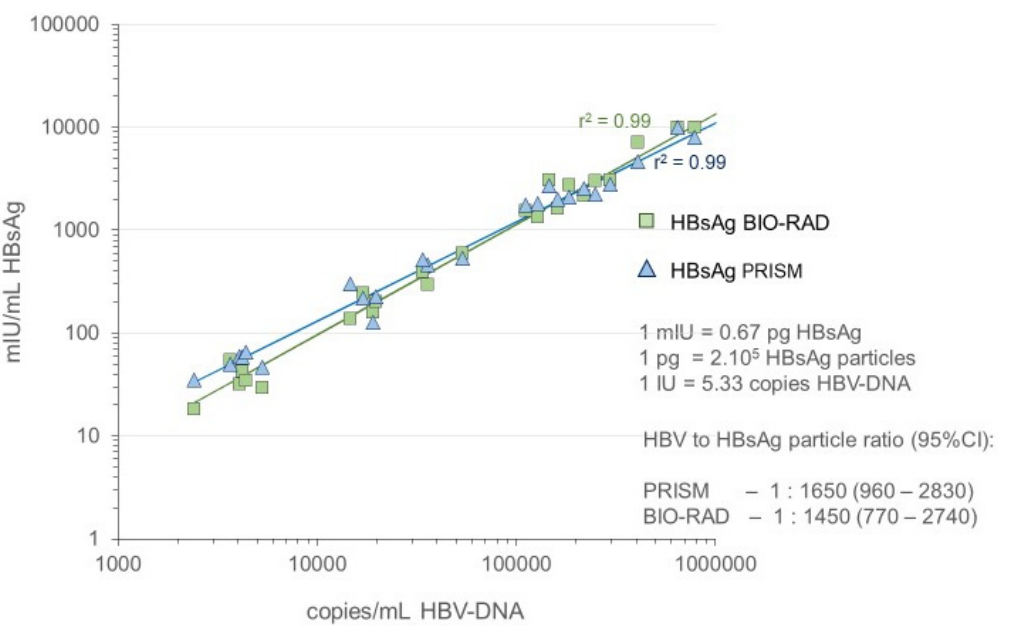
Figure 4. Correlation between Log copies/mL HBV-DNA (bDNA 3.0 assay) and Log mIU/mL HBsAg (PRISM and BIO-RAD assays) measured with 25 ramp-up phase samples from five seroconversion panels (#6284, #6289, #6292, #11006, and #11008) and estimation of ratio between number of HBV virions (HBV ‐ DNA copies) and subviral 20 nm HBsAg particles.